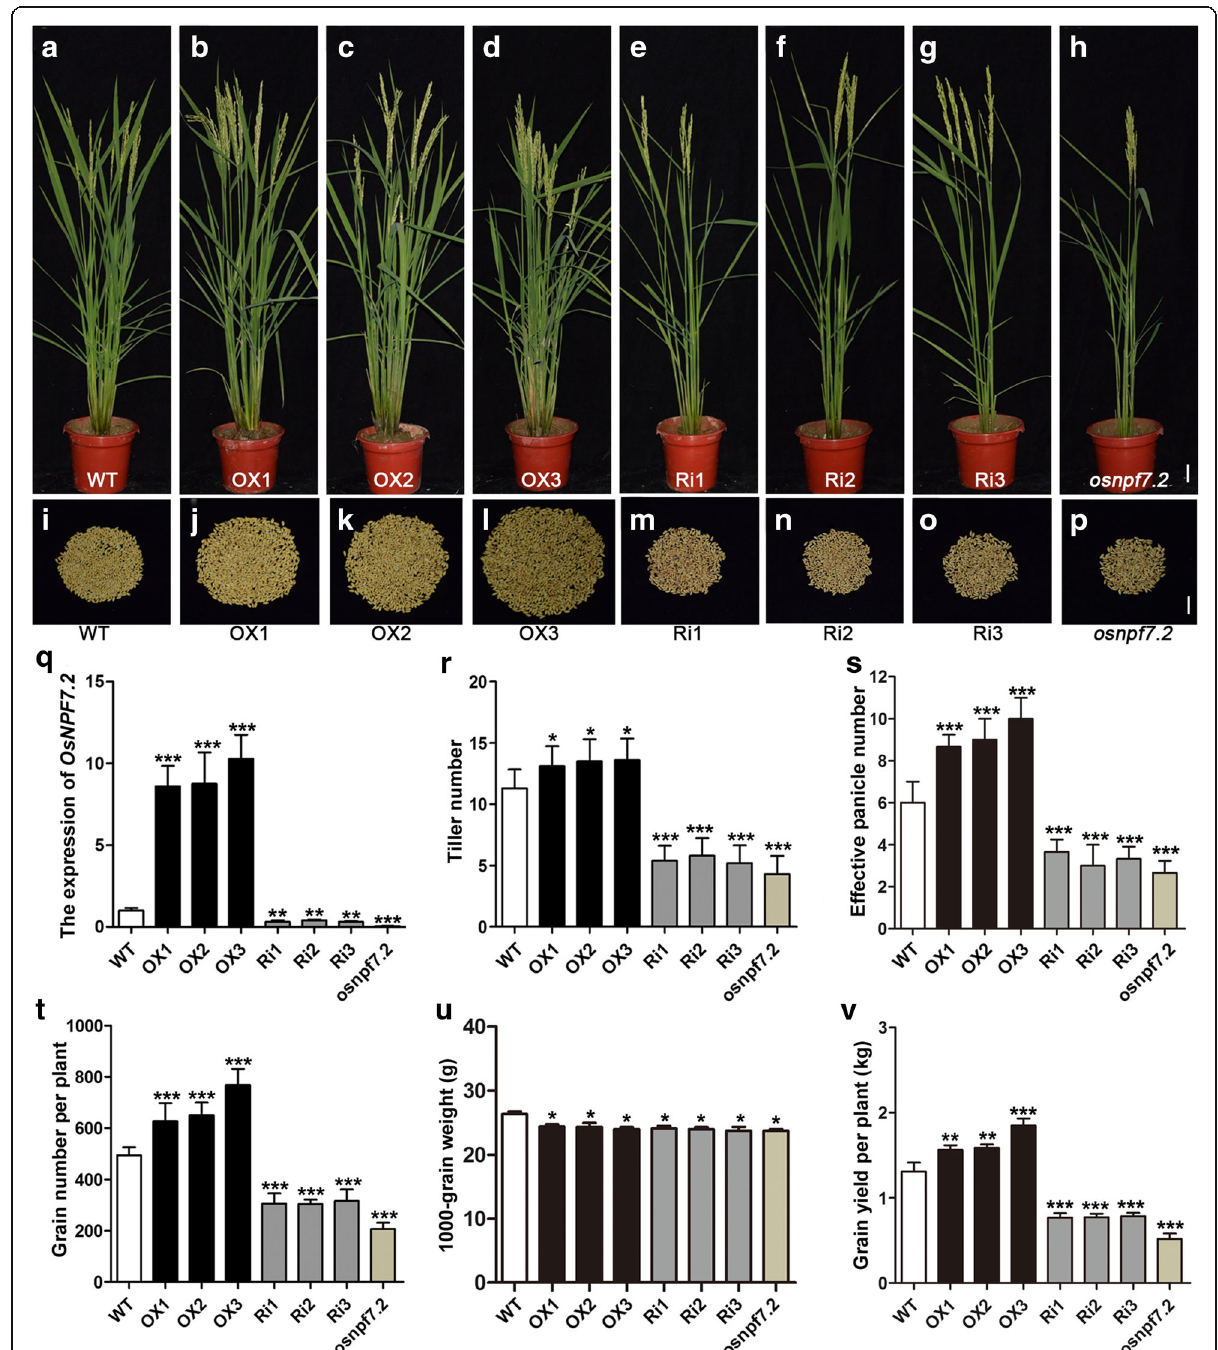
Fig. 1 Characterization of transgenic lines of OsNPF7.2 . a-h Phenotypic analysis of WT, OX lines, Ri lines and mutant osnpf7.2 at mature stage. Bar = 5 cm. i-p Comparison of total grain number among WT, OX lines, Ri lines and osnpf7.2 . Bar = 5 cm. q Transcript abundance of OsNPF7.2 in tiller buds among WT, OX lines, Ri lines and osnpf7.2 . r-v Comparison of agronomic traits including tiller number ( r ), effective panicle number ( s ), grain number per plant ( t ), 1000-grain weight ( u ) and grain yield per plant ( v ) among WT, OX lines, Ri lines and osnpf7.2 . WT, OX and Ri were abbreviations for wild type, over-expression and RNA-interference, respectively. Data in q-v are shown as means ± SD ( n =10) from three replicates. A student ’ s t-test was used to generate P values; “ *, ** and *** ” indicate significance at P <0.05, P <0.01 and P <0.001,